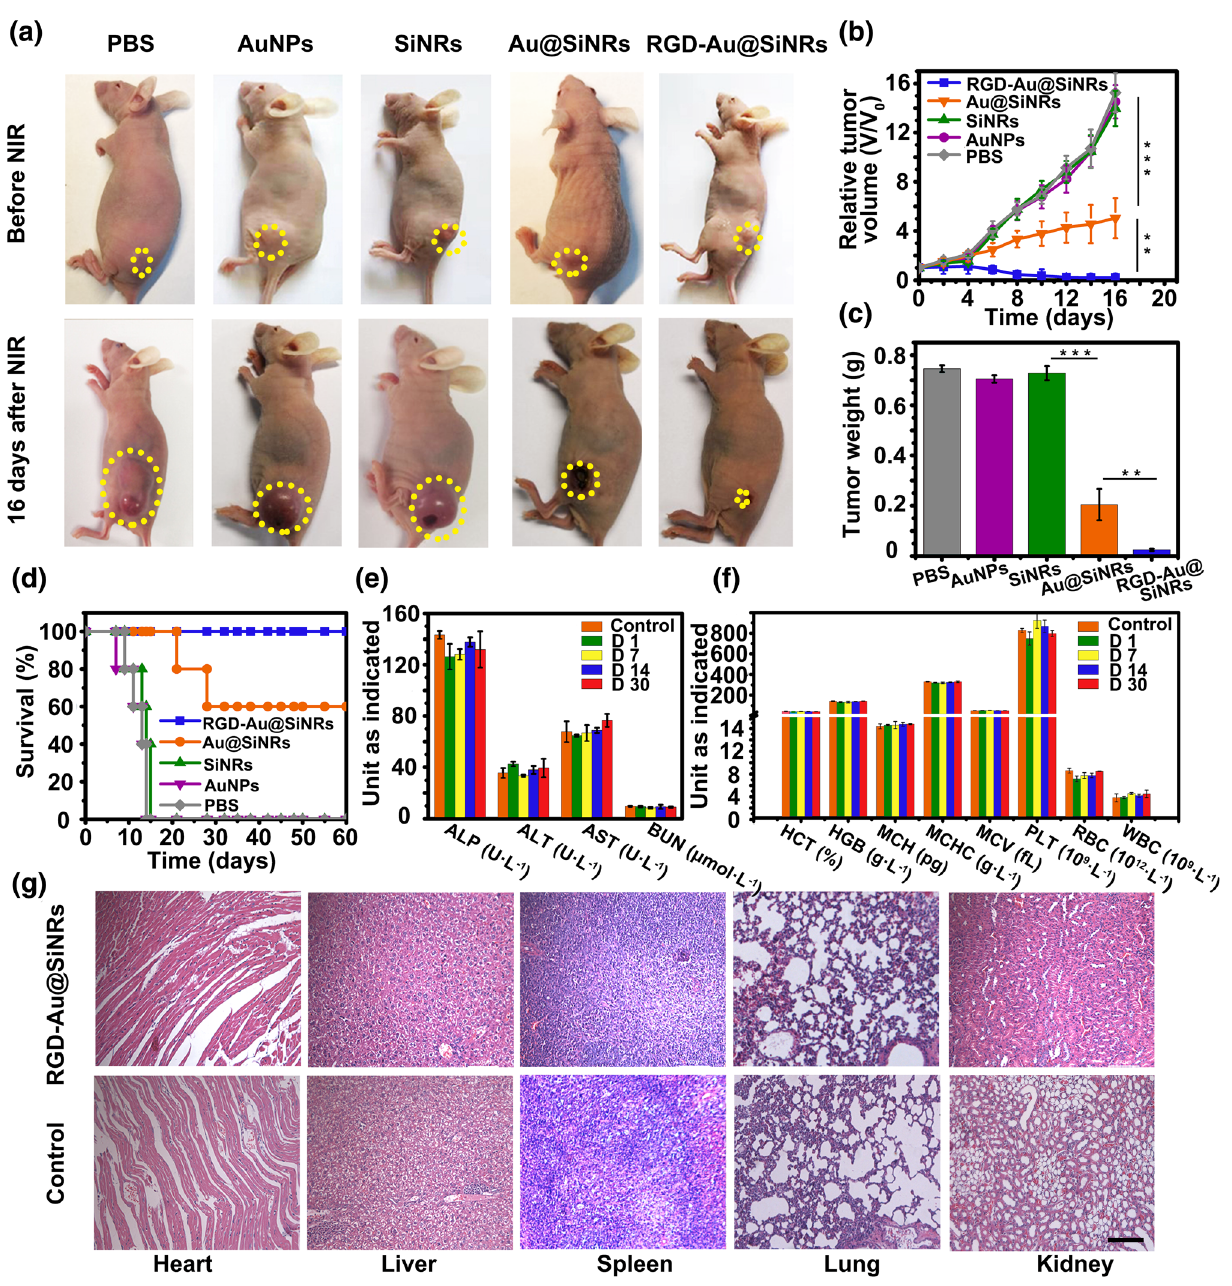
Fig. 5 Photothermal therapy and safety assessment. a Photos of representative mice before and after the treatment with different agents and NIR irradiation. b Growth curves of tumor volumes of mice groups with NIR irradiation. c Weight of the excised tumors from the PTT‑treated mice. d Survival curves of PTT‑treated mice. e Serum biochemistry data including alkaline phosphatase, alanine aminotransferase, and aspartate ami‑ notransferase, and blood urea nitrogen levels of control and RGD‑Au@SiNRs‑treated healthy mice. f Complete blood counts: hematocrit, hemo‑ globin, mean corpuscular hemoglobin, mean corpuscular hemoglobin concentration, mean corpuscular volume, blood platelets, red blood cells, blood levels of white blood cells, and platelets of control and RGD‑Au@SiNRs‑treated healthy mice. g H&E staining of various organ tissues harvested from tumor‑bearing mice at the end of treatment. Asterisk (**) indicates p < 0.01; (***) means p <